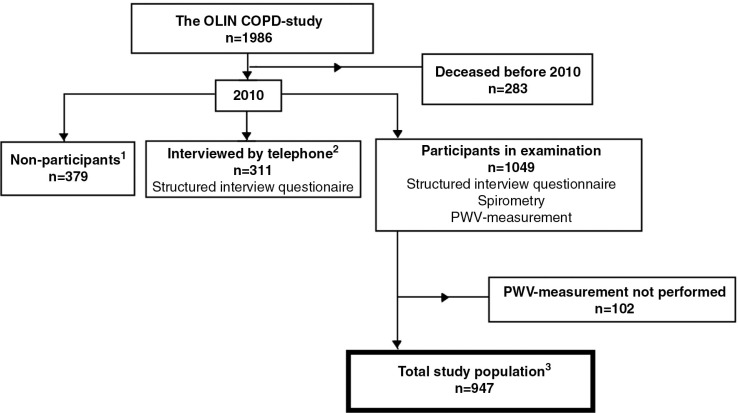
Flowchart of the recruitment of the study population.1Not willing to participate.2Not able to attend the examination.3In 17 cases, spirometry data was missing and collected from the previous year.